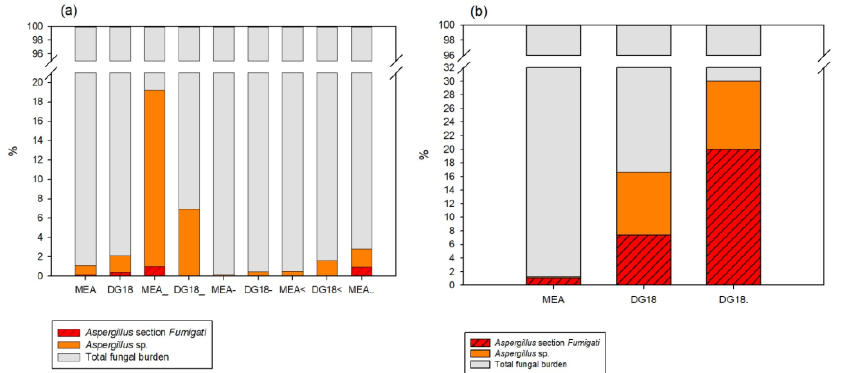
Figure 1. Aspergillus sp. and Aspergillus section Fumigati distribution in the PHCC samples ( a ) and CH samples ( b ) (Adapted from [5,27,28]). CH samples ( b ) (Adapted from [5,27,28]).